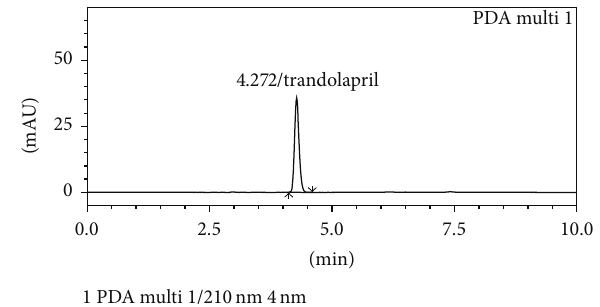
Figure 2: Representative chromatogram showing signal of tran- dolapril in the selected mobile phase.